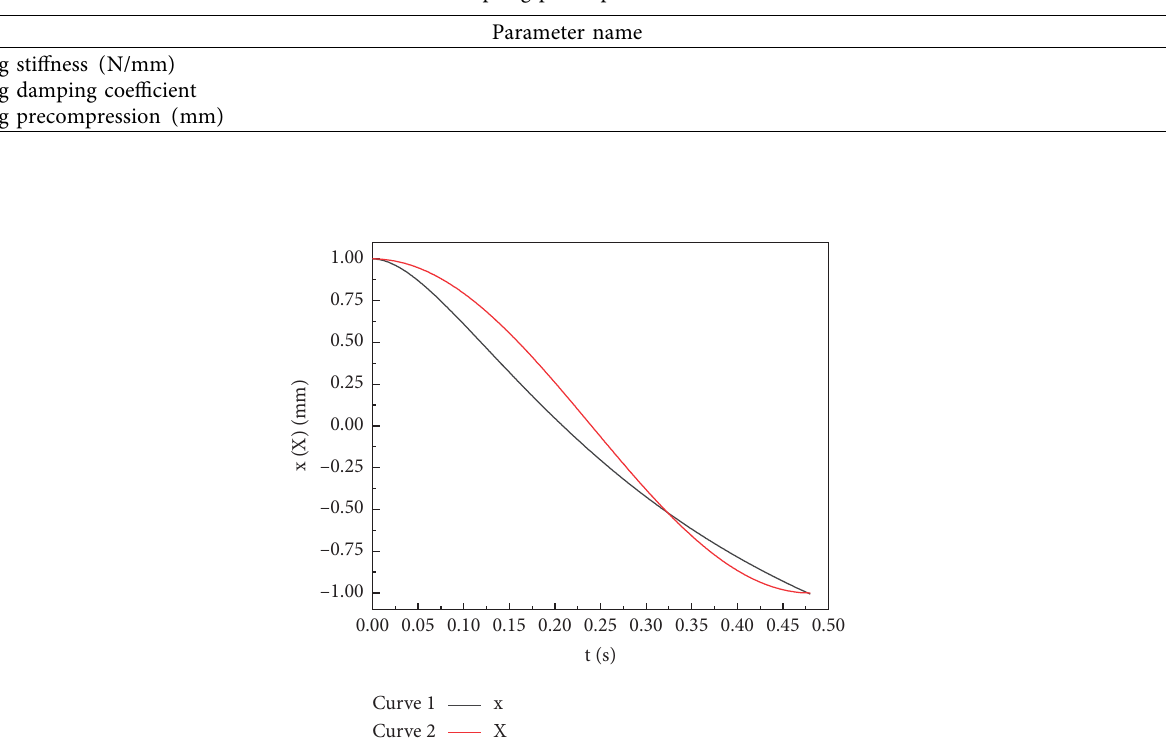
Table 2: Spring preset parameter table.